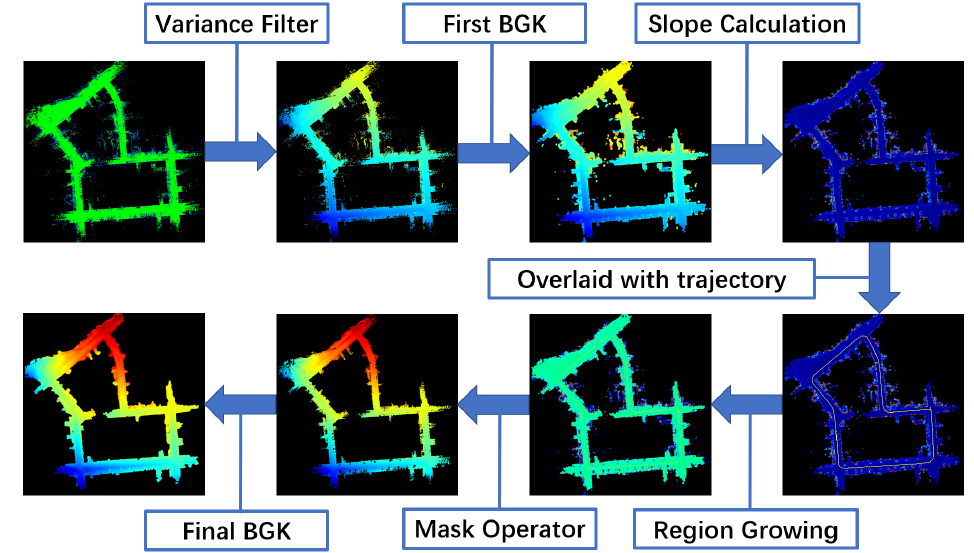
Figure 2. The flowchart of the proposed terrain modeling approach. From top left to bottom left, points are colored according to variance, height, height, slope, slope, region mask, height and height